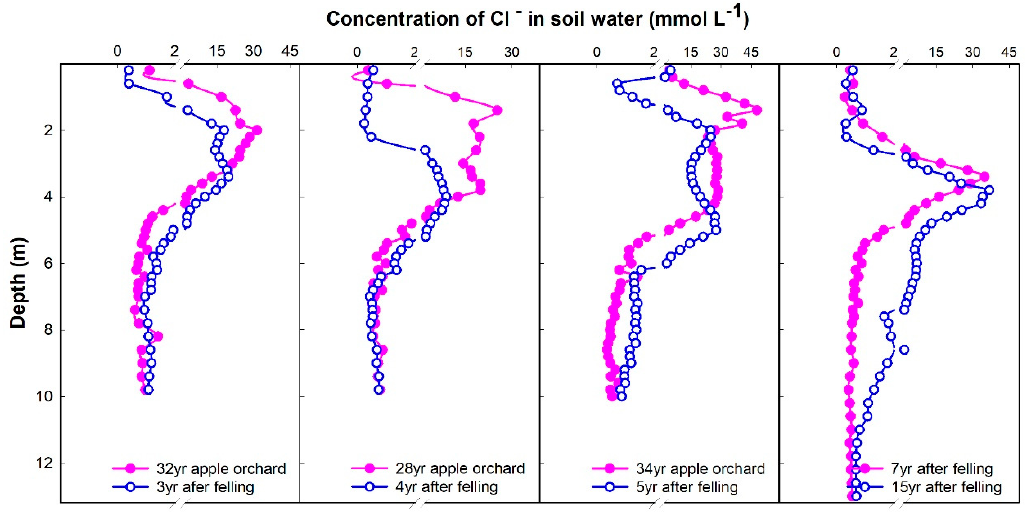
Figure 3. Concentration and storage of Cl − in soil water of 4 recovery sites.